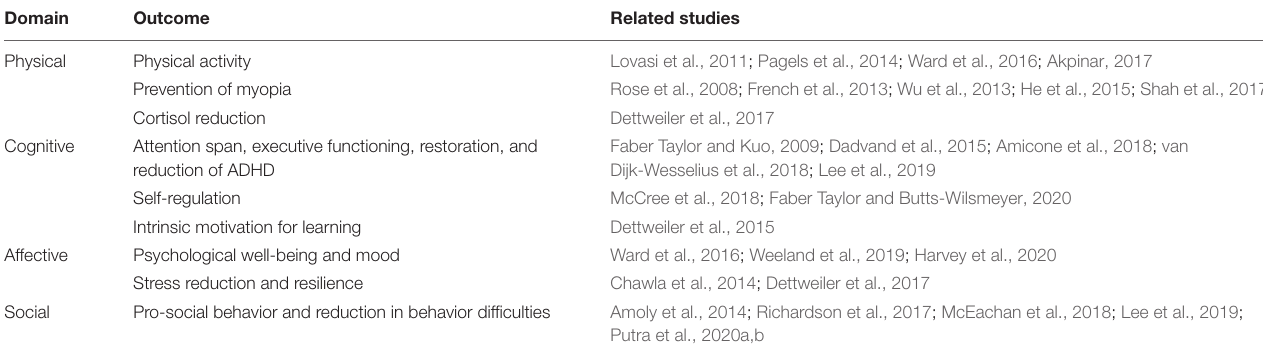
TABLE 1 | Examples of benefits of nature contact and access for